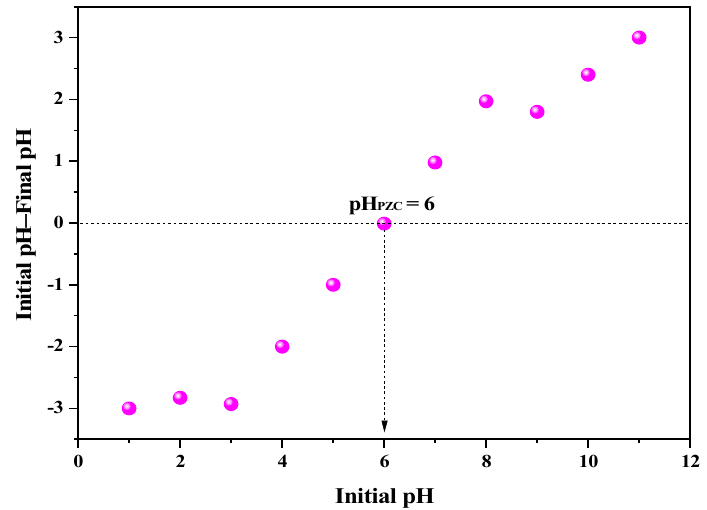
Figure 4. Relationship between initial and final pH to determine the pH PZC .